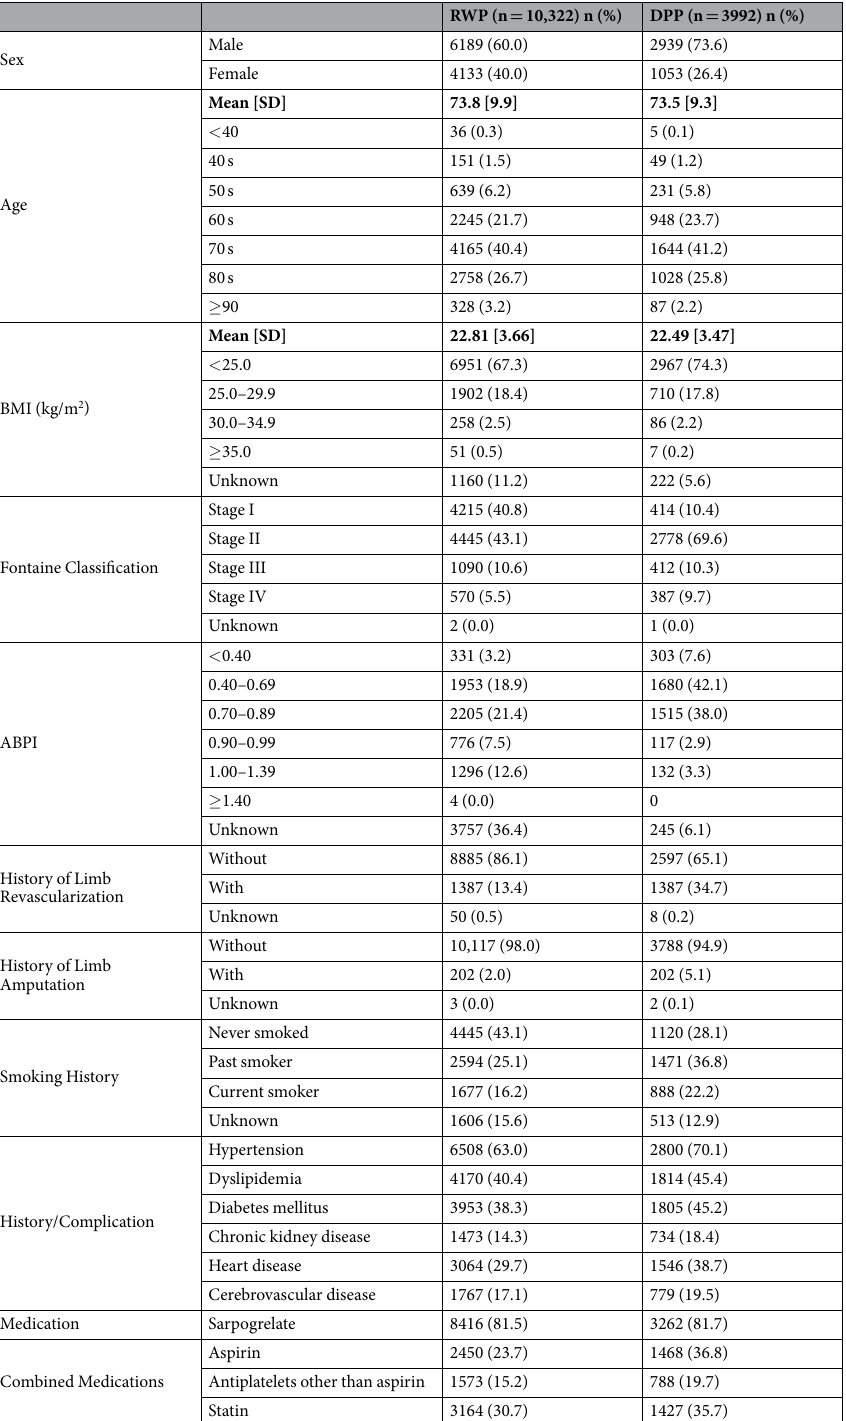
Table 1. Baseline Characteristics. Abbreviations: ABPI, ankle-brachial pressure index; BMI, body mass index; DPP, definite peripheral arterial disease population; RWP, real-world population; SD, standard